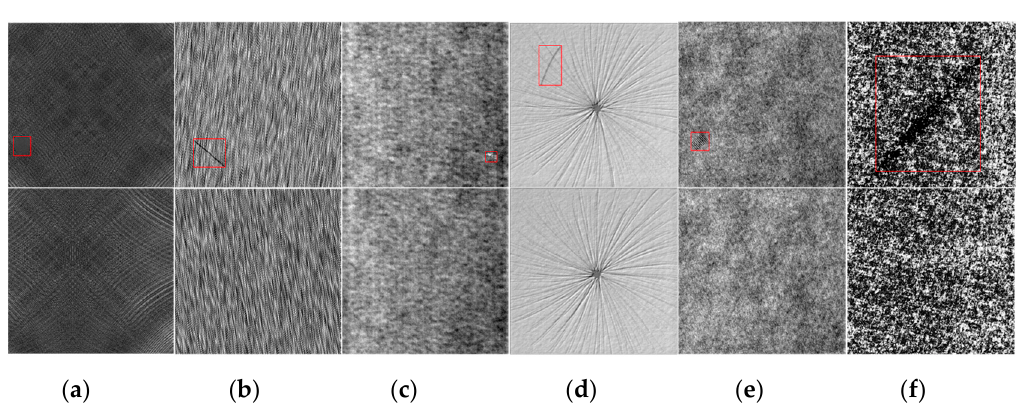
Figure 4. Examples of the DAGM_2007 defect dataset. Each column represents a type of defect, and the defect areas are labeled by the red bounding boxes. ( a ) classes1; ( b ) classes2; ( c ) classes3; ( d ) classes4; ( e ) classses5; ( f ) classes6.